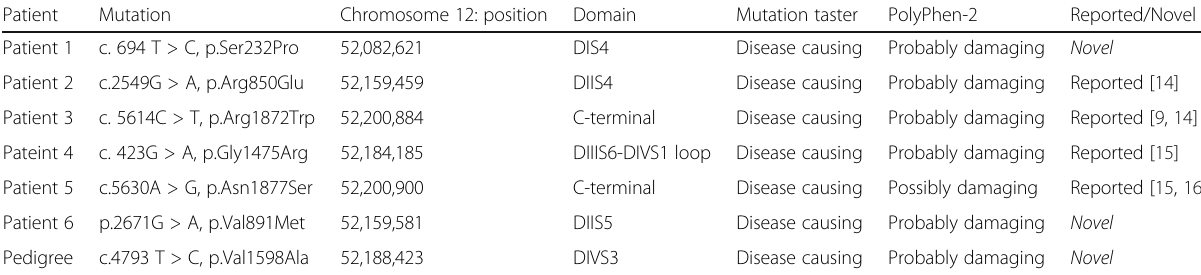
Table 3 Seven SCN8A (NM_014191.3) mutations identified in our